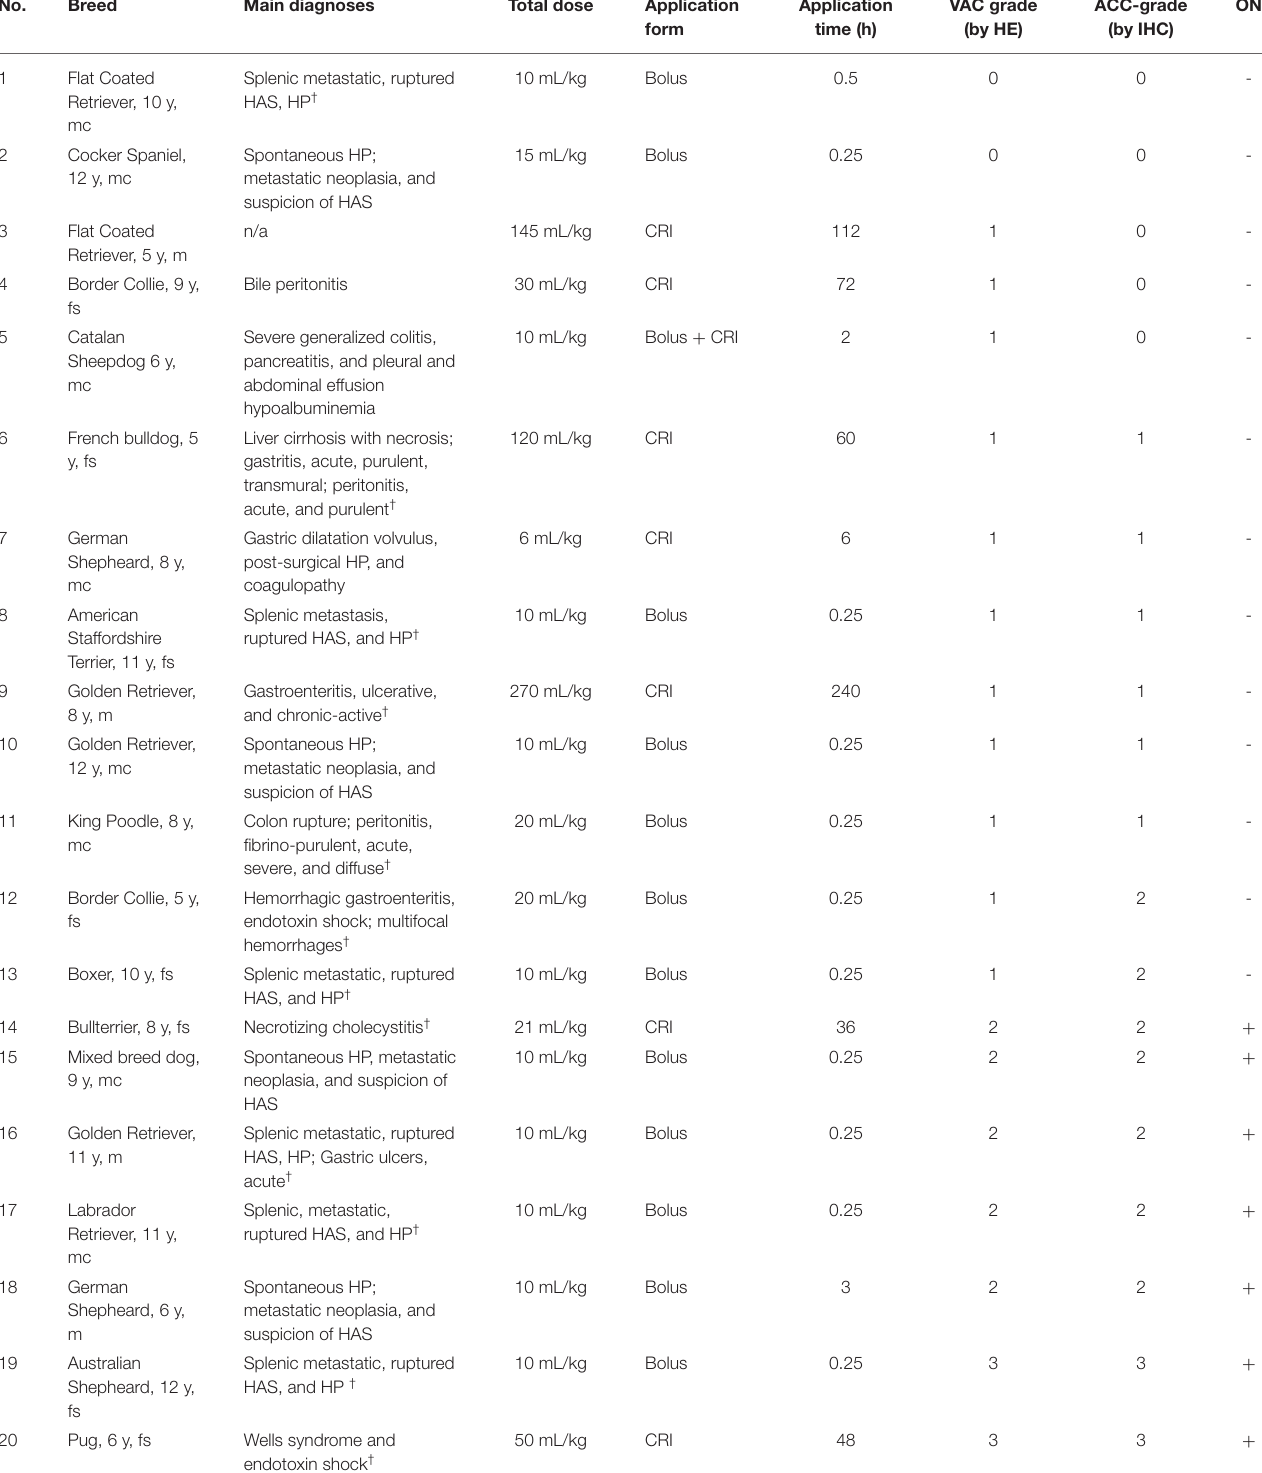
TABLE 2 | Patient characteristics, cause of death, diagnosis, total HES dose, HES application form, HES total application time, grading of renal tubular vacuolization (VAC grade), grading of renal HES accumulation (ACC grade), and the presence ( + ) or absence (–) of ON in 20 dogs. No. Breed Main diagnoses Total dose Application